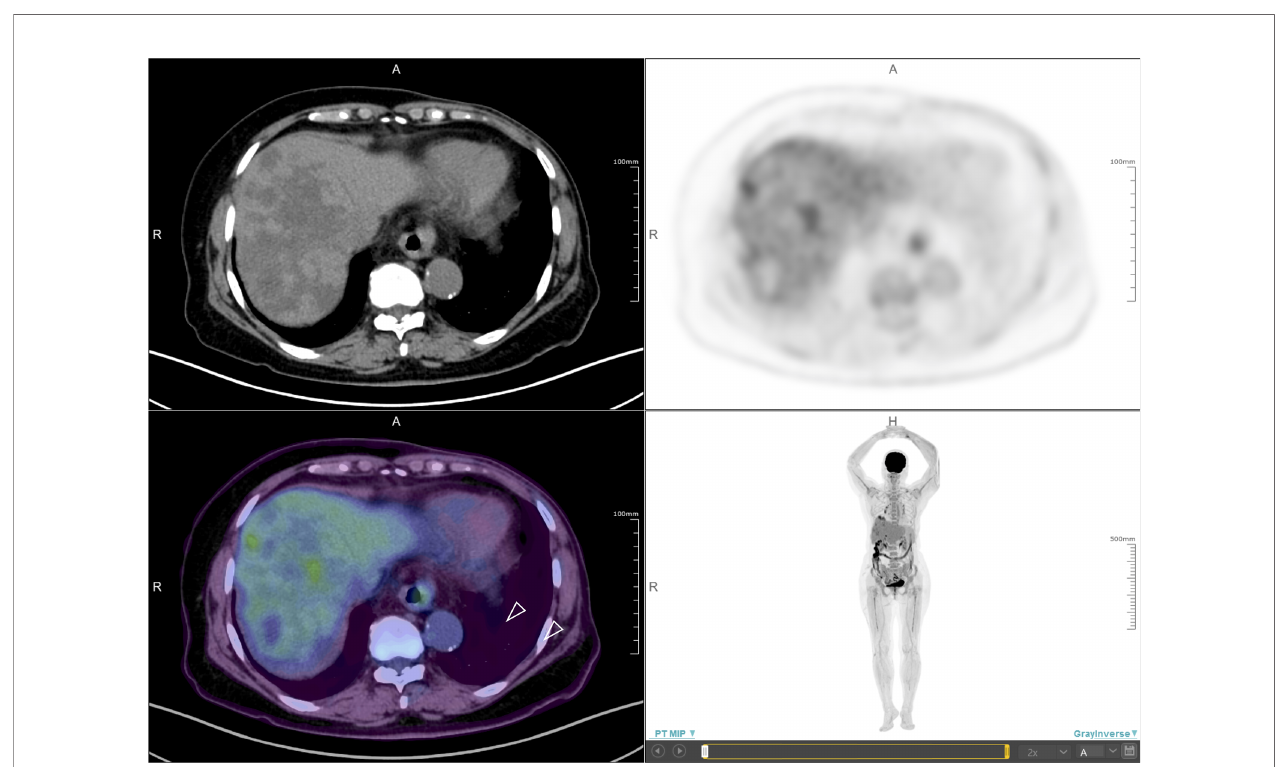
FIGURE 5 | Positron emission tomography/computed tomography (PET/CT). PET/CT scan con fi rmed slightly high fl uorodeoxyglucose ( 18 F-FDG) uptake with an SUV max of 5.9 for limited metastatic liver lesions (white